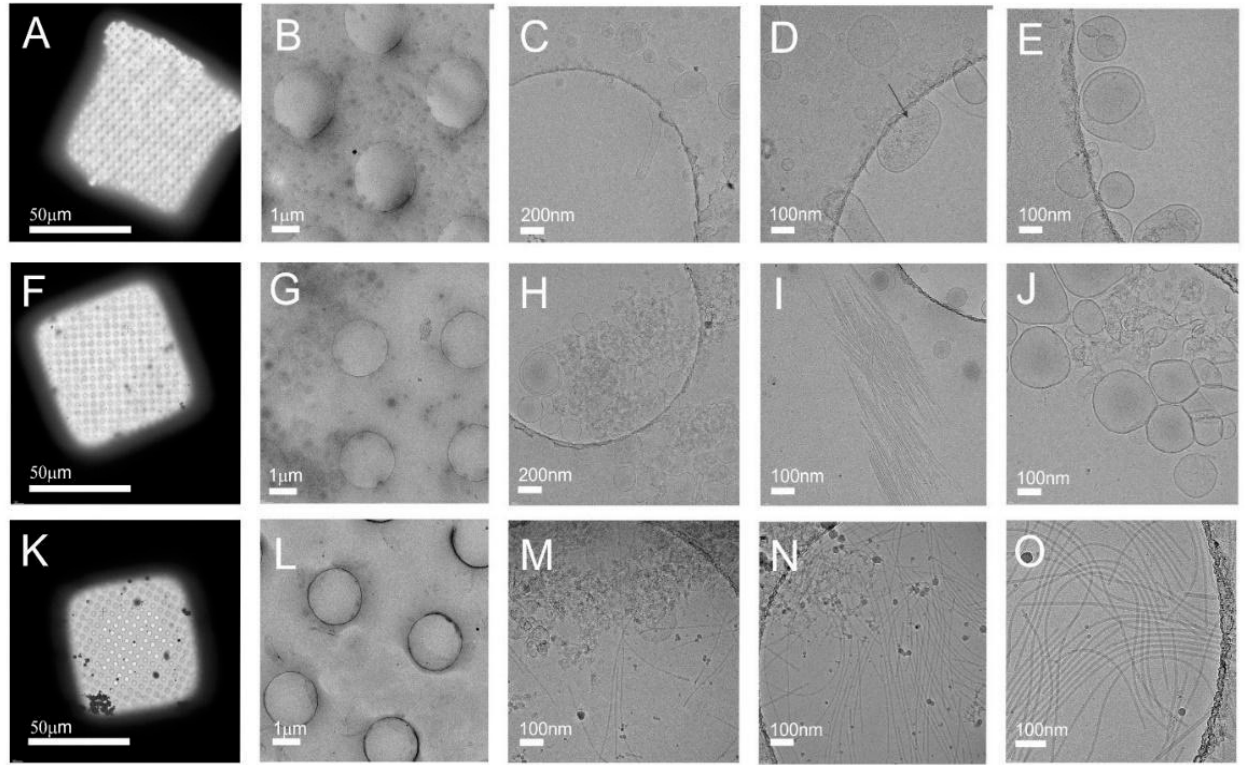
Figure 8. Cryo-TEM images of three fractions of isolate from the homogenate of tomato infected by the virus: Fraction 4 ( A – E ), Fraction 7 ( F – J ) and Fraction 9 ( K – O ). Fraction 4 exhibits mostly EVs; Fraction 7 exhibits sub-micron-sized particles, vesicles and virions; and Fraction 9 exhibits mostly virions.